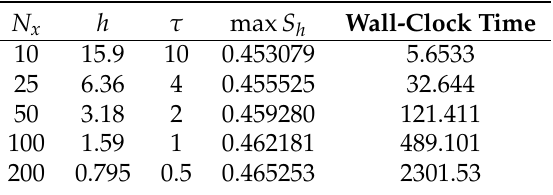
Figure 5. Hydrate saturation for different N x and h denoted by dx. See Table 6 for the related quantitative information extracted from the simulations. Table 6. Accuracy and complexity of the computational model depending on N x , with the time step τ adjusted to vary linearly with h . As the quantity of interest depending on N x we show the saturation values at T = 25 K . This table complements the plots in Figure